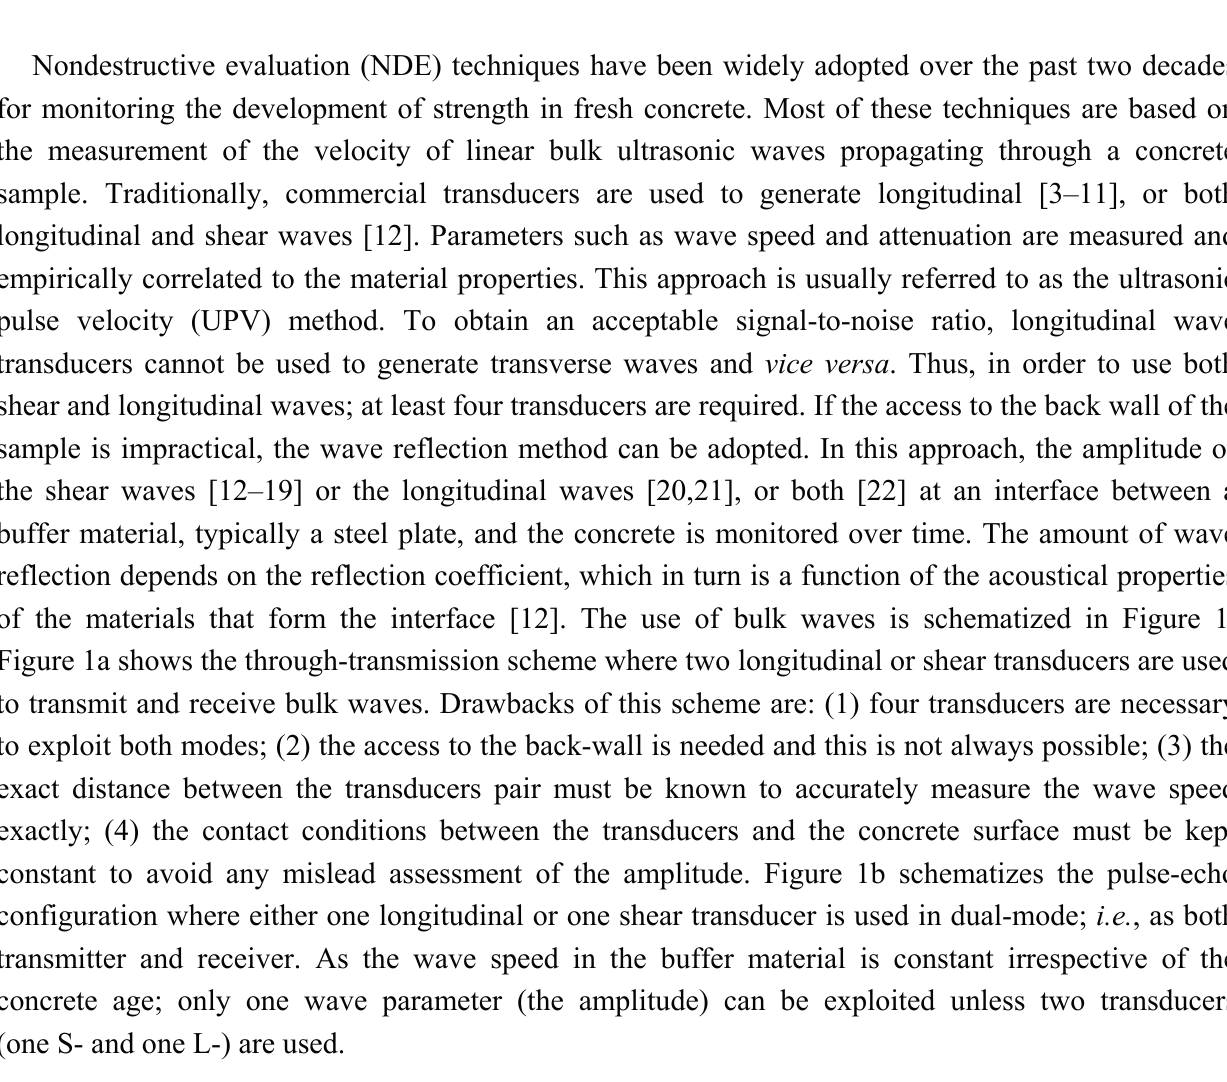
Figure 1. ( a ) Through-transmission; ( b ) Pulse-echo